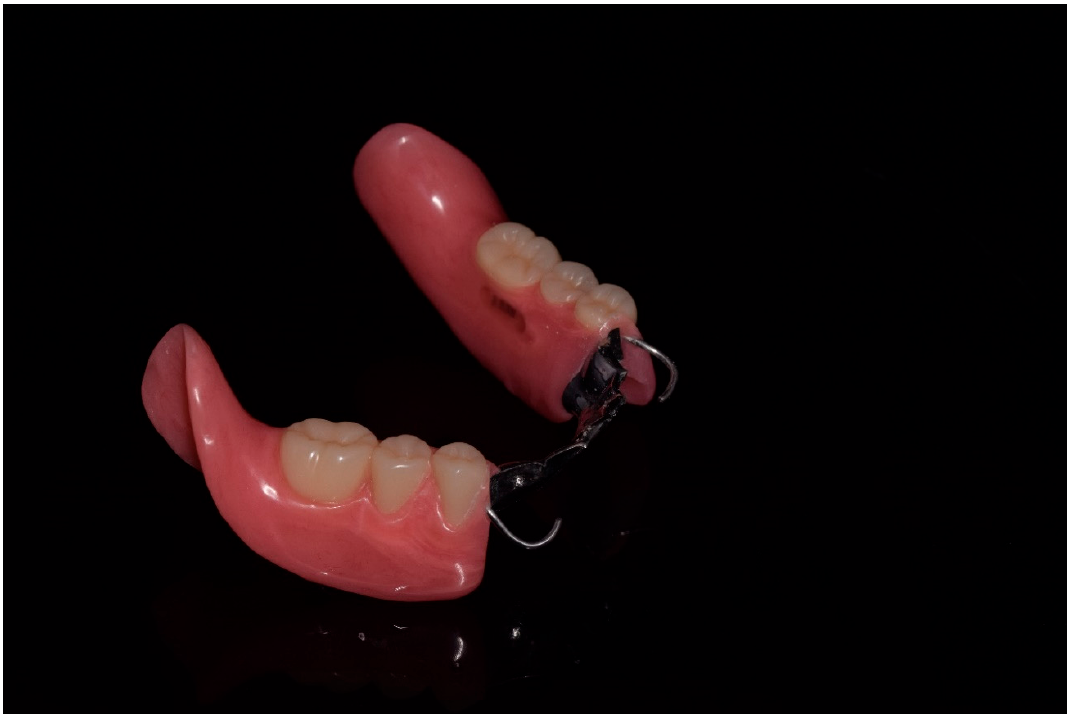
Figure 3. Finished cobalt chromium removable partial denture with wrought wire clasps. While framework fabrication methods vary, the steps of tooth setting, acrylic resin processing, and final finishing and polishing remain the same.